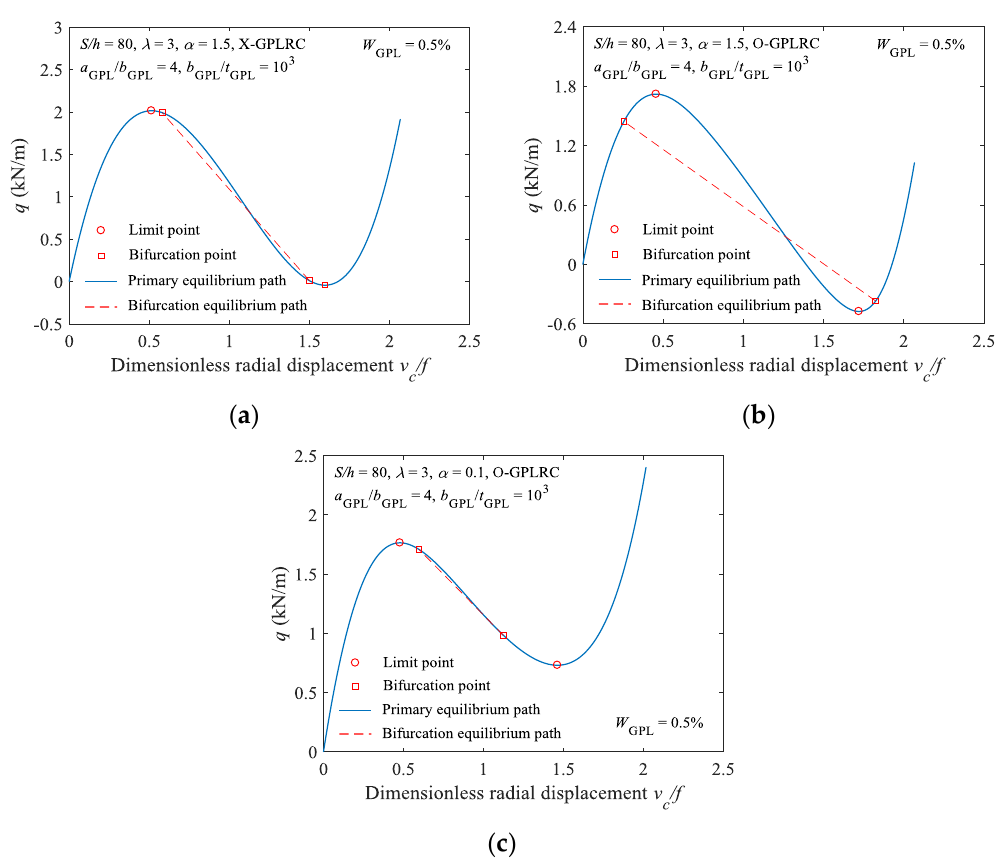
Figure 7. Effect of constraint stiffness and GPLs distribution patterns on buckling model: ( a ) Load displacement curve (X-GPLRC, α = 1.5); ( b ) load displacement curve (O-GPLRC, α = 1.5); and, ( c ) load displacement curve (O-GPLRC, α = 0.1).